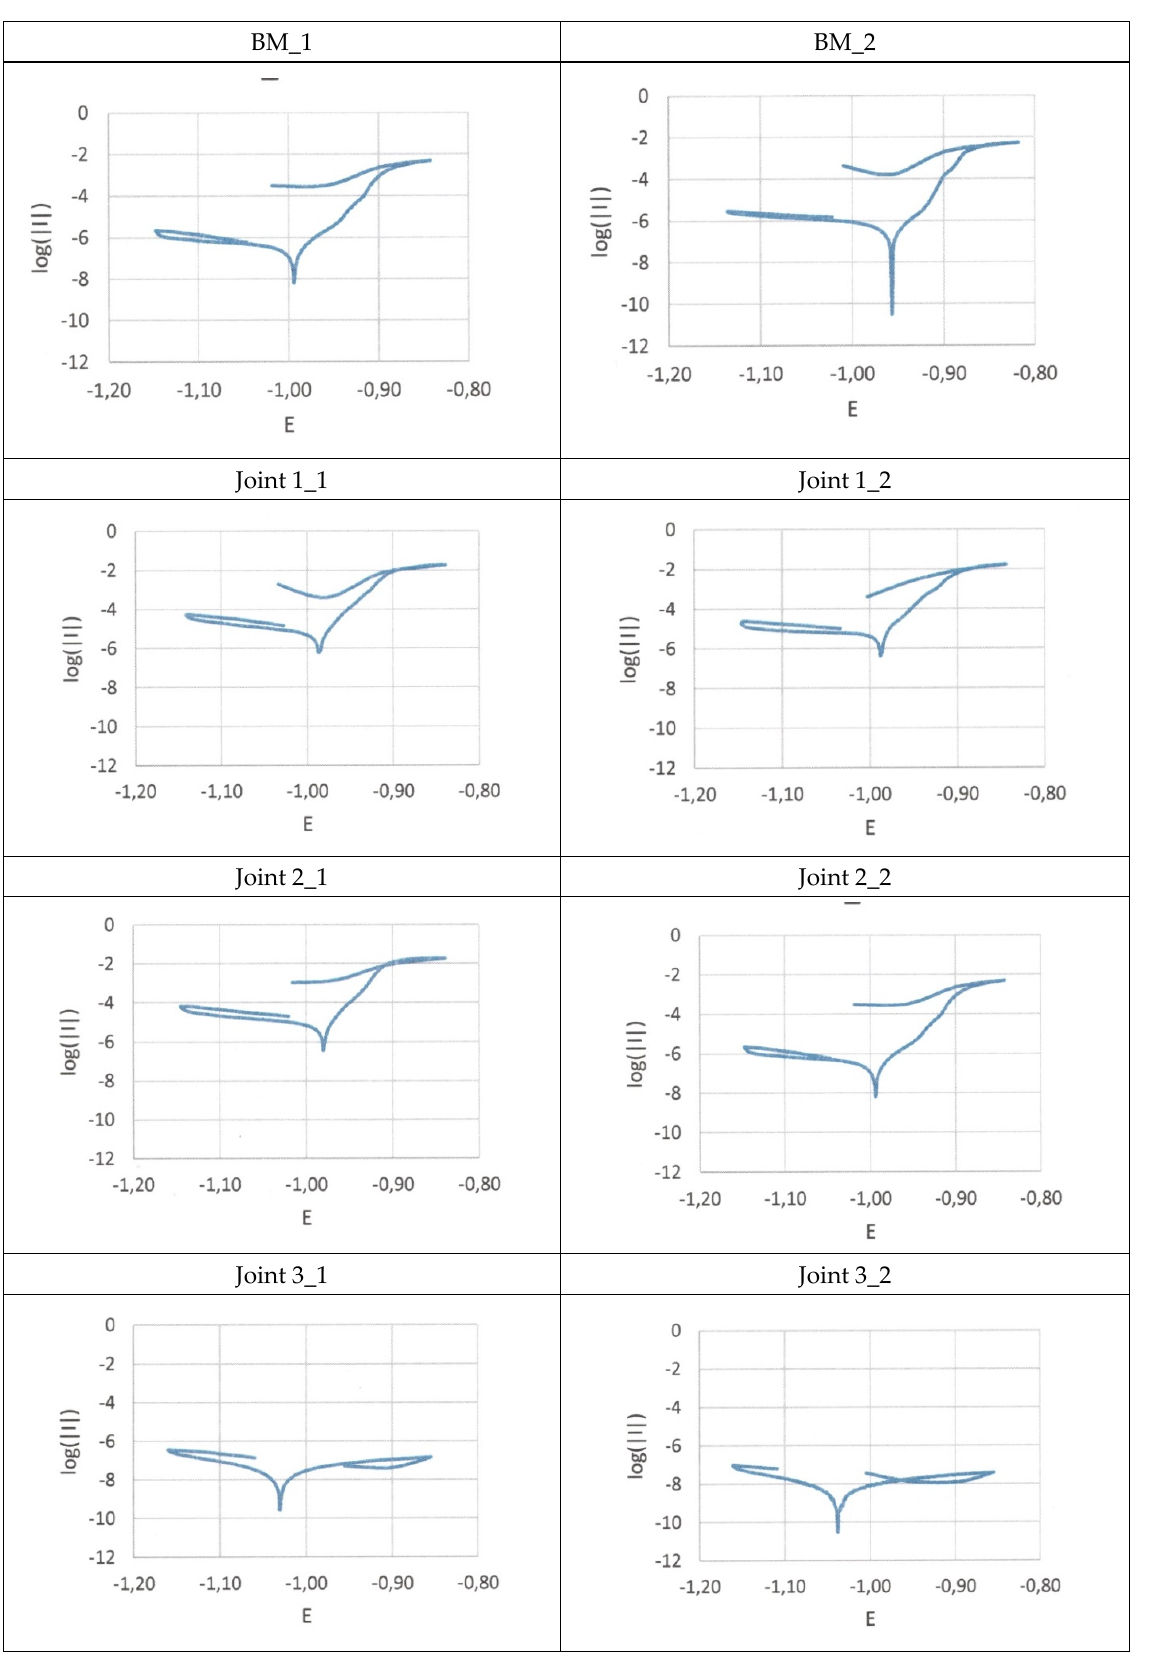
Figure 7. Polarization curves.